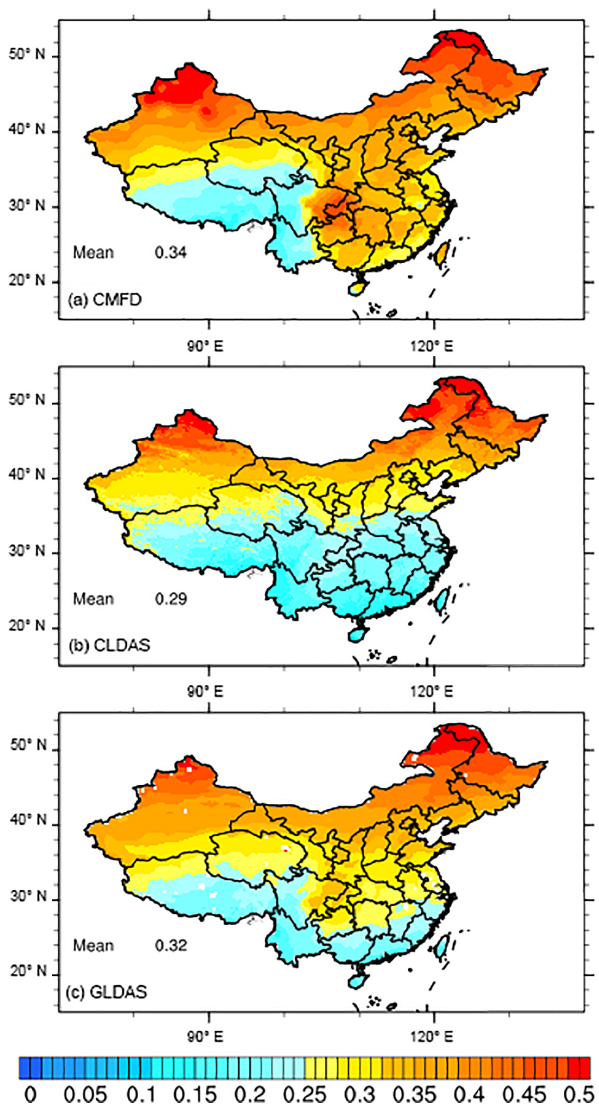
Figure 13. Spatial distributions of TCV for shortwave radiation products from the three forcing data